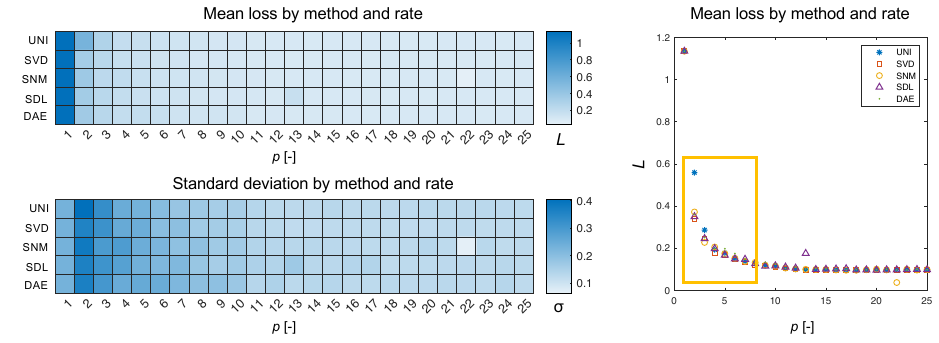
Figure 7. Here, we show the mean loss and standard deviation for each method as a function of the sampling rate. The methods are abbreviated by three-letter codes for visual clarity. The mean SAM loss, L , is displayed as a heat-map and as a Pareto plot. The difference between methods is greatest in for p < 5 (boxed region).